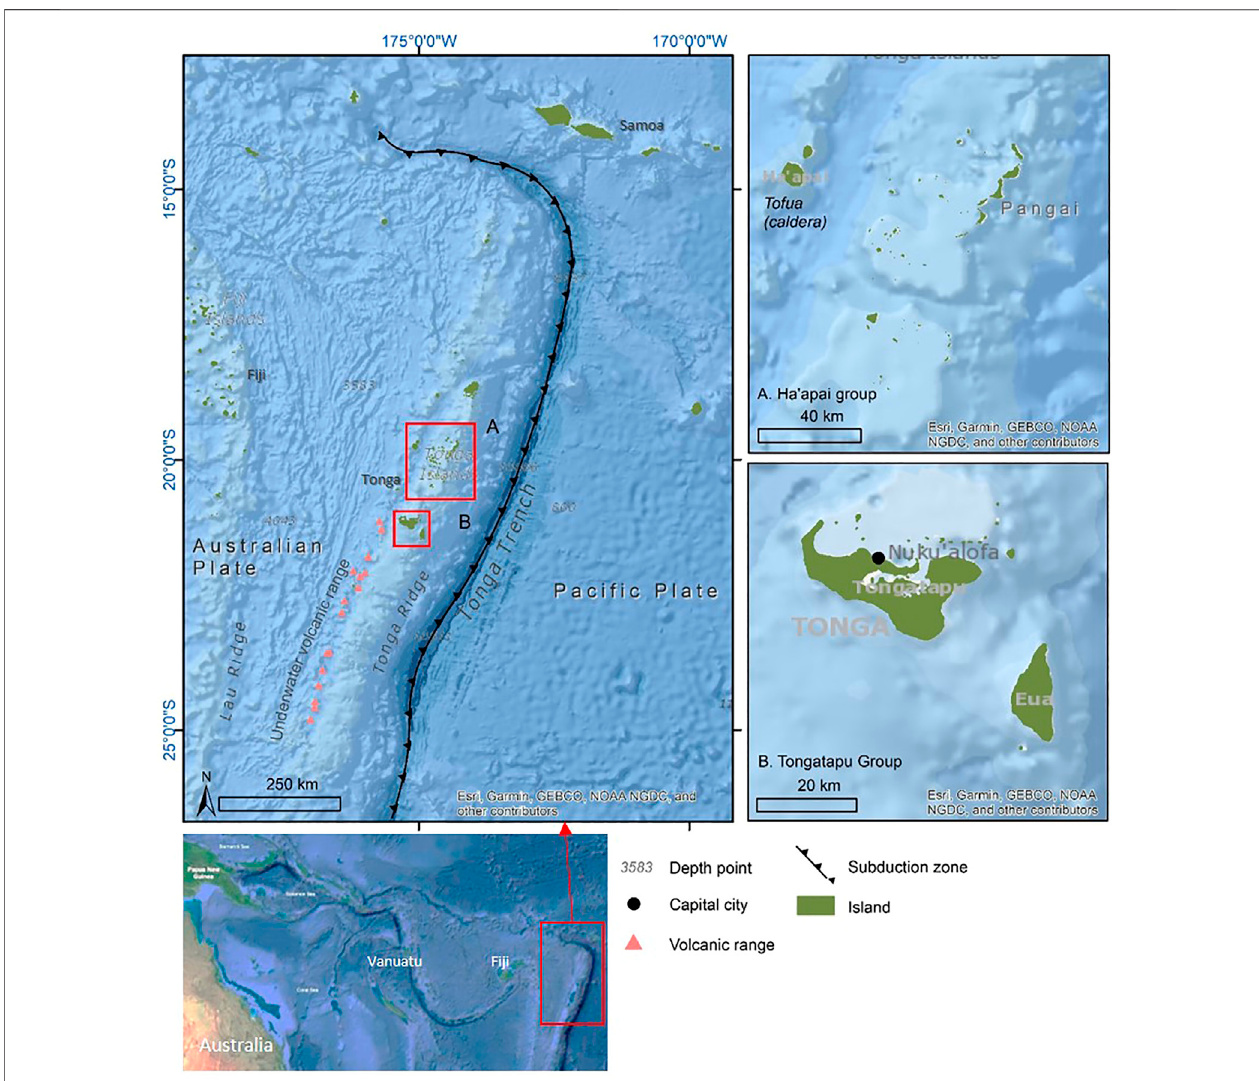
FIGURE 1 | The Tongan archipelago in the Southwest Paci fi